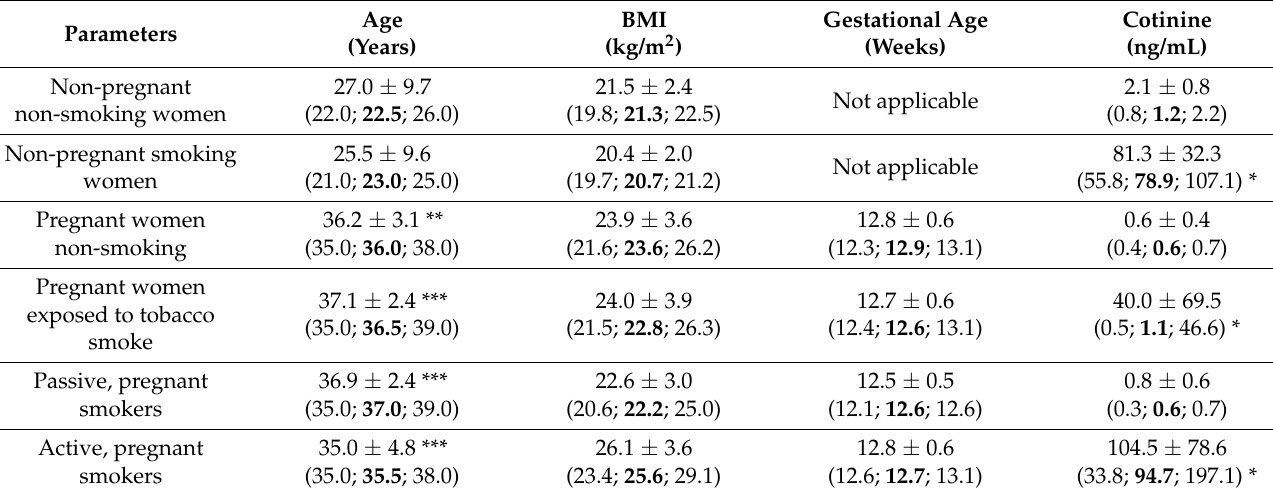
Table 1. Characteristics of studied